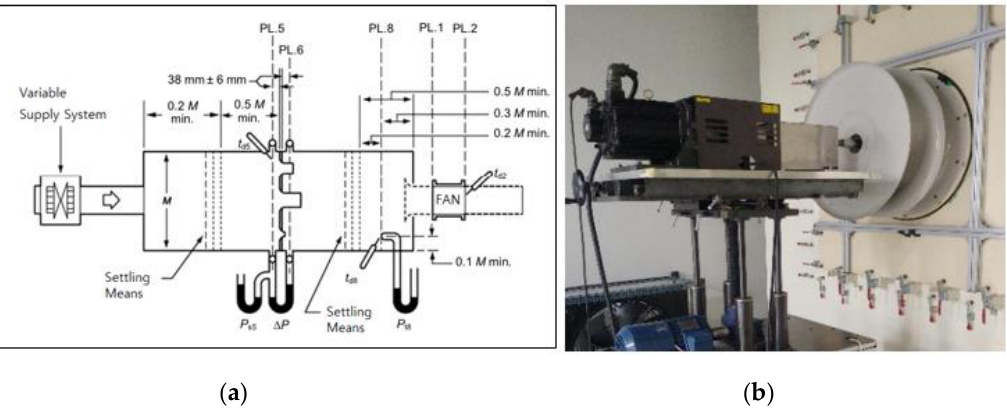
Figure 4. ( a ) Schematic diagram of multi-nozzle chamber; ( b ) Test scene.